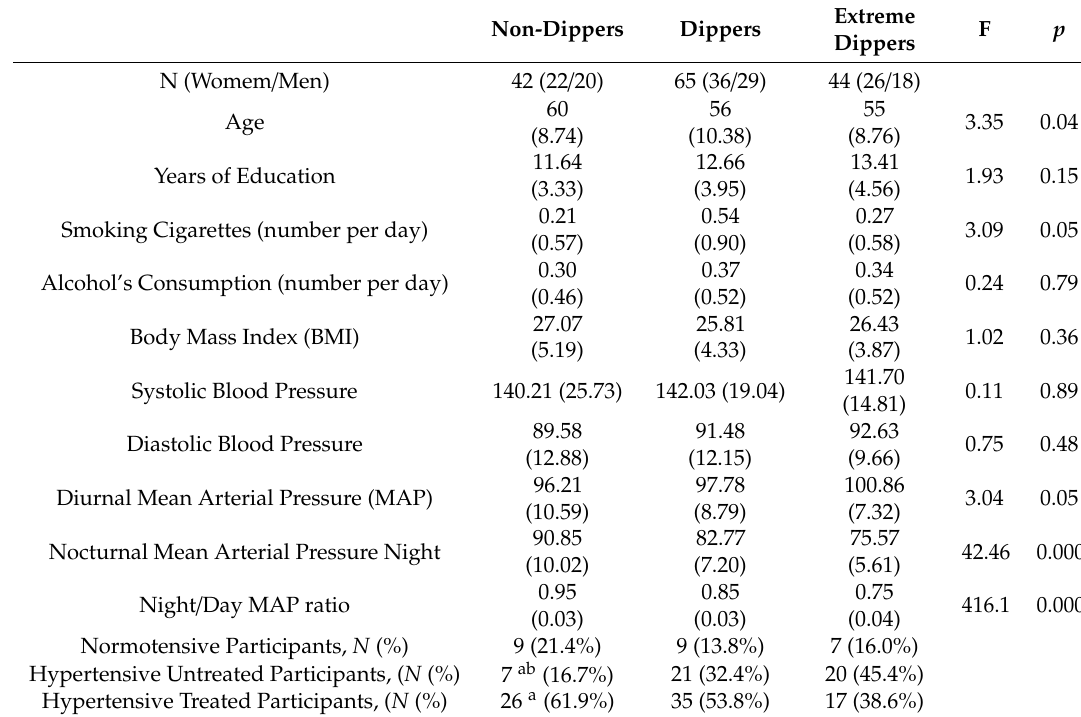
Table 1. Means ( ± SD) of the main characteristics of the three groups of participants.